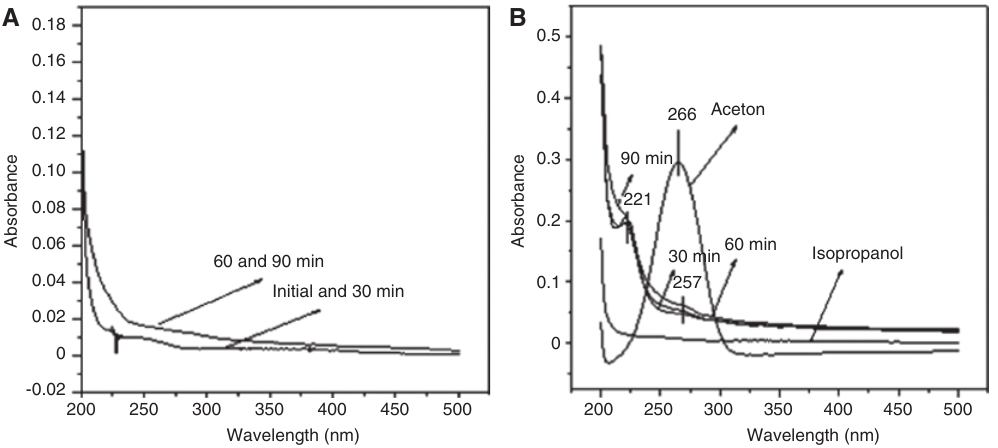
/G and (B) CdS-TiO /G as a photocatalyst of monochromatic light at 450 nm 2 2